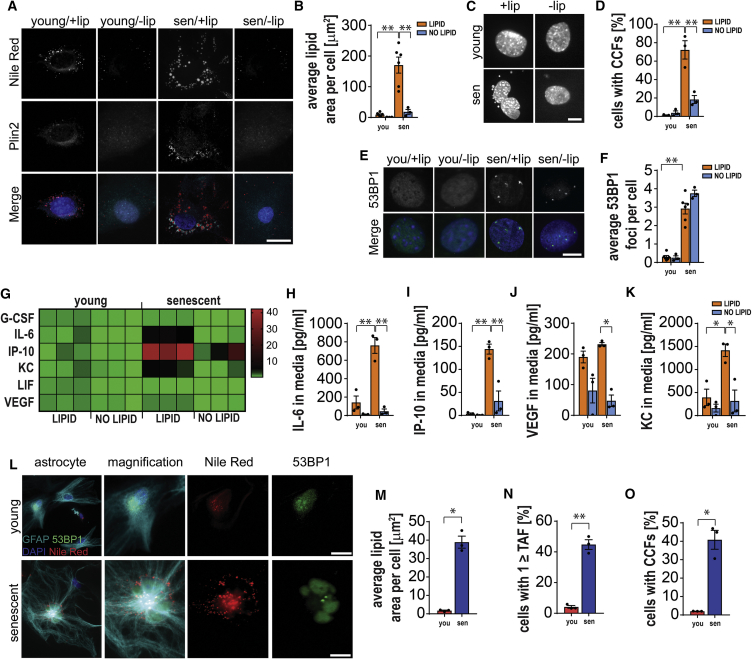
ALISE Phenotype Drives CCF Accumulation and the SASPSimilar to glia in the brains of obese mice, mouse adult fibroblasts (MAFs) show an accumulation of lipids in senescence (ALISE) phenotype.(A–F) Depletion of lipids from culture media reduces area of lipid droplets in MAFs. (A) The ALISE phenotype in MAFs is characterized by an increased area of lipid droplets surrounded by Plin2 vesicles (scale bars, 20 μm). (B) Quantification of Nile Red-positive staining in non-senescent young (you) and senescent (sen) MAFs (p < 0.0001, p = 0.0004). (C and D) Suppression of the ALISE phenotype reduces frequencies of cytoplasmic chromatin fragments (CCF) in senescent fibroblasts (p < 0.0001, p = 0.0006) (scale bars, 10 μm), but (E) and (F) does not affect number of 53BP1 DNA damage foci (p = 0.0973) (scale bars, 10 μm).(G–K) Senescent fibroblasts show increased secretion of SASP components including Il-6, KC (Cxcl1), and Ip-10 (Cxcl10) that is alleviated upon suppression of the ALISE phenotype. (G) Heatmap shows fold change in secretion of SASP components in cell culture media over a 72-hr time period when compared to non-senescent fibroblasts cultured with lipid-containing media. Each square represents a separate biological replicate, i.e., MAFs isolated from a different mouse donor. Concentration of SASP components in culture media with and without lipids (ALISE phenotype suppression) for (H) Il-6 (p = 0.0003, p < 0.0001), (I) Ip-10 (Cxcl10) (p = 0.0002, p = 0.0008), (J) Vegf (p = 0.6407, p = 0.003), and (K) Kc (Cxcl1) (p = 0.0114, p = 0.0075).(L) Images show accumulation of lipid droplets in senescent but not non-senescent GFAP-positive astrocytes (scale bars, 20 μm).(M–O) Characterization of senescence in astrocytes. Senescent astrocytes show (M) the ALISE phenotype measured using Nile Red staining (t(2.034) = 11.32, p = 0.0073), (N) increased frequencies of telomere dysfunction measured as the frequency of cells with 1 or more telomere associated DNA damage focus (TAF) (t(4) = 12.45, p = 0.0002), and (O) increased frequencies of CCF (t(2) = 7.551, p = 0.0171). Senescence was induced by X-ray irradiation (10Gy) and established within 14–21 days post-irradiation.Data are from n = 3–6 mice per group. Mean ± SEM plotted. ∗p ≤ 0.05 and ∗∗p ≤ 0.001.